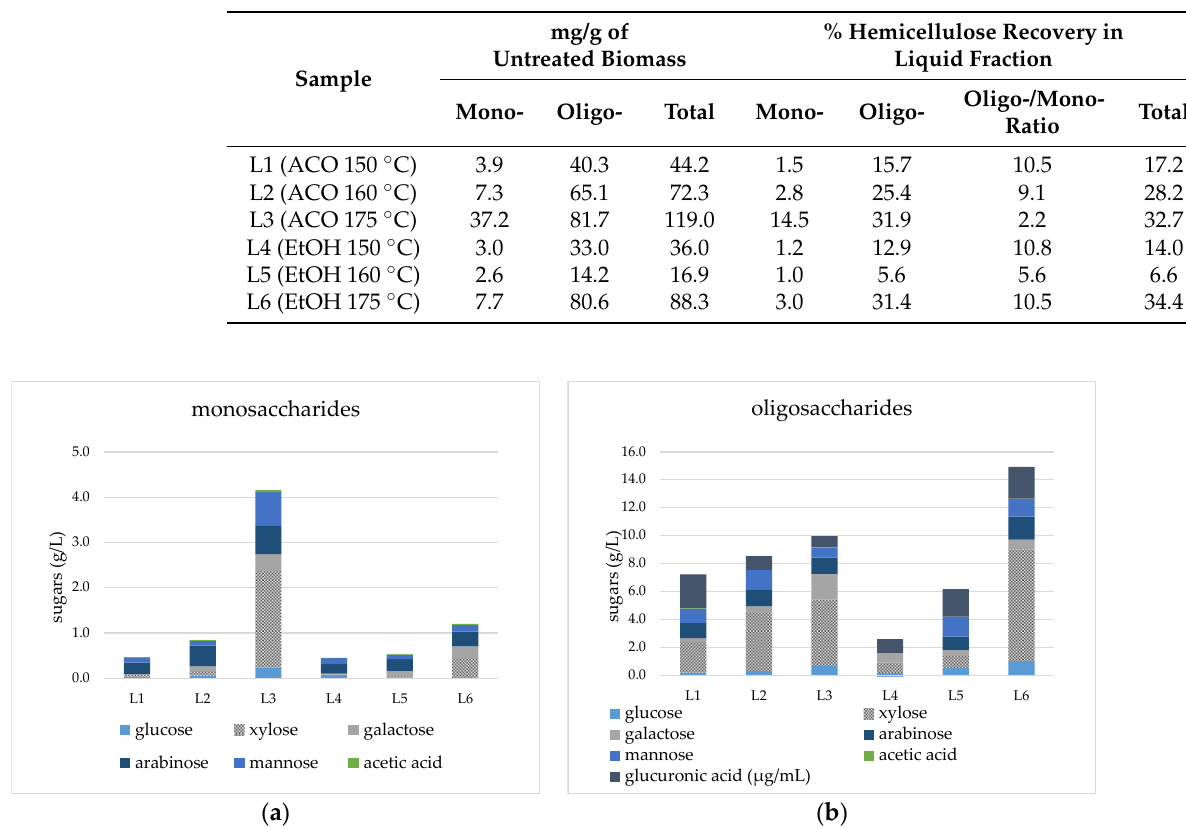
Table 2. Compositional analysis of monosaccharides/oligosaccharides in the liquid fraction. Standard error is ≤ 2.5% in all measurements.